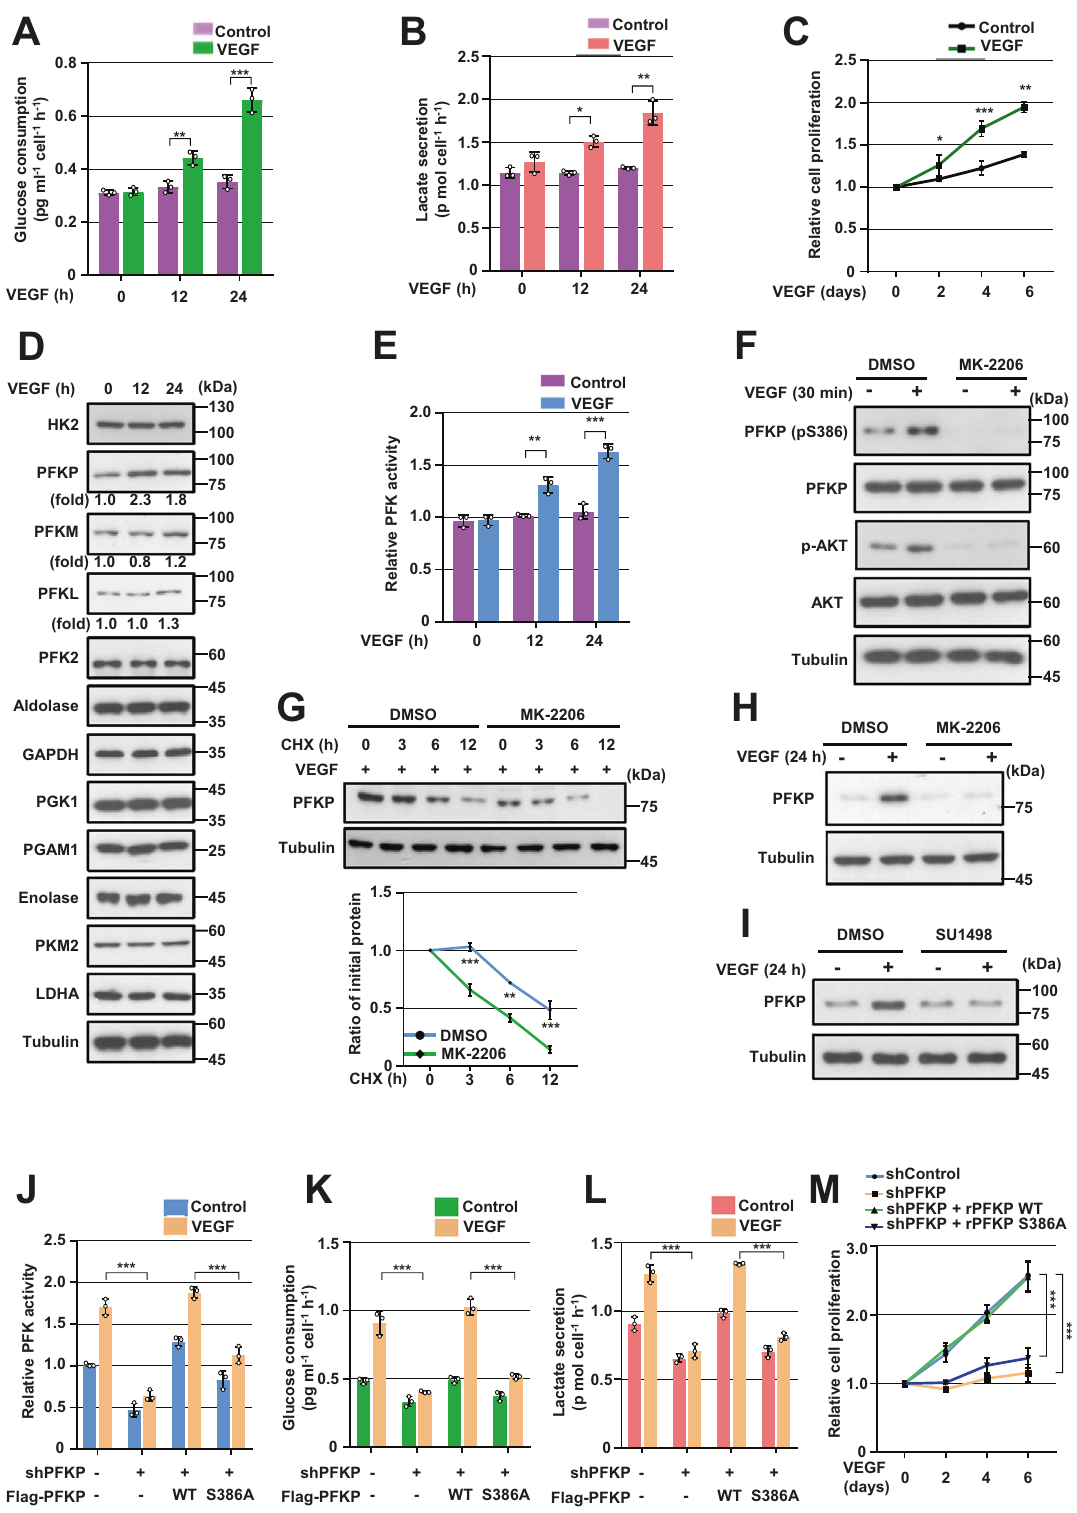
(Fig. 5G and Supplementary Fig. S5H) and PFKP expression (Fig. 5H and Supplementary Fig. S5I) in GSCs, LN229, and A172 cells were largely decreased by pretreatment with MK-2206. The VEGF- induced PFKP expression was blocked by pretreatment of SU1498, a VEGFR2 tyrosine kinase inhibitor, in GBM cells (Fig. 5I